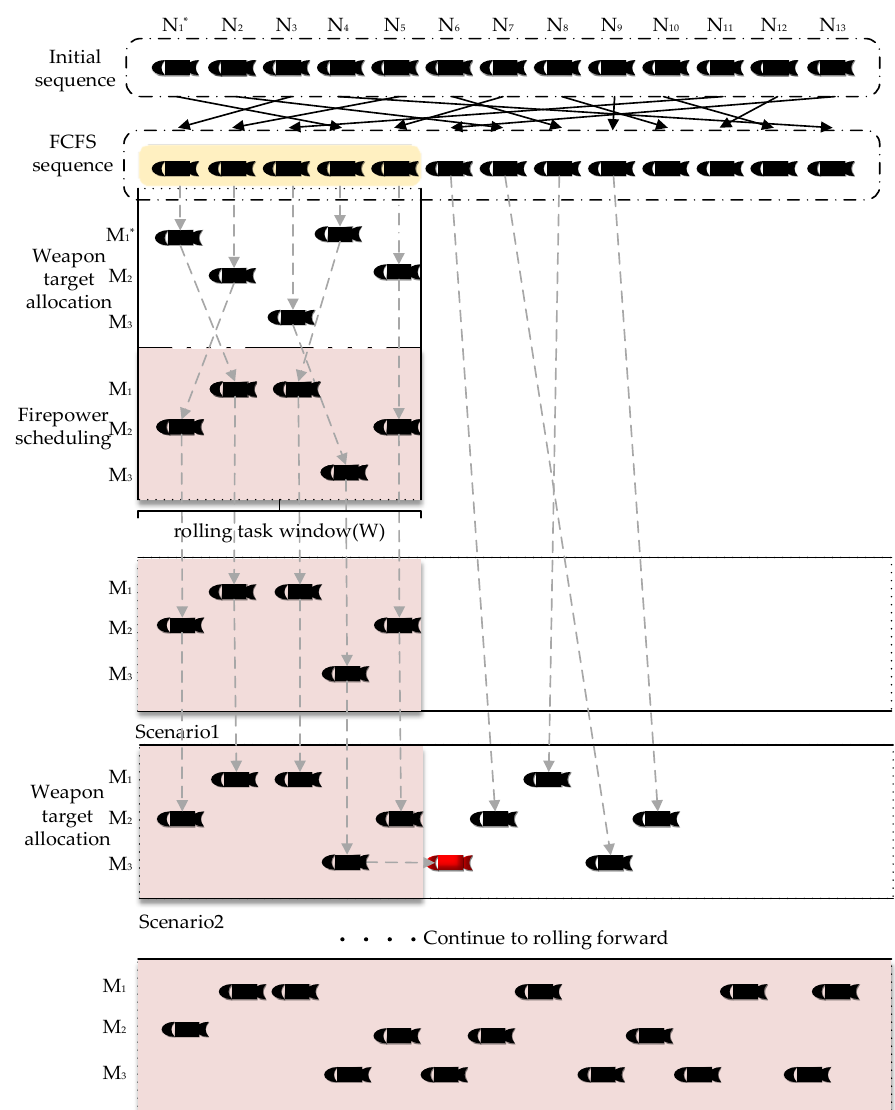
Figure 2. Flowchart of rolling horizon scheduling strategy. * M i in the figure denotes weapon i , and N j denotes incoming target j .